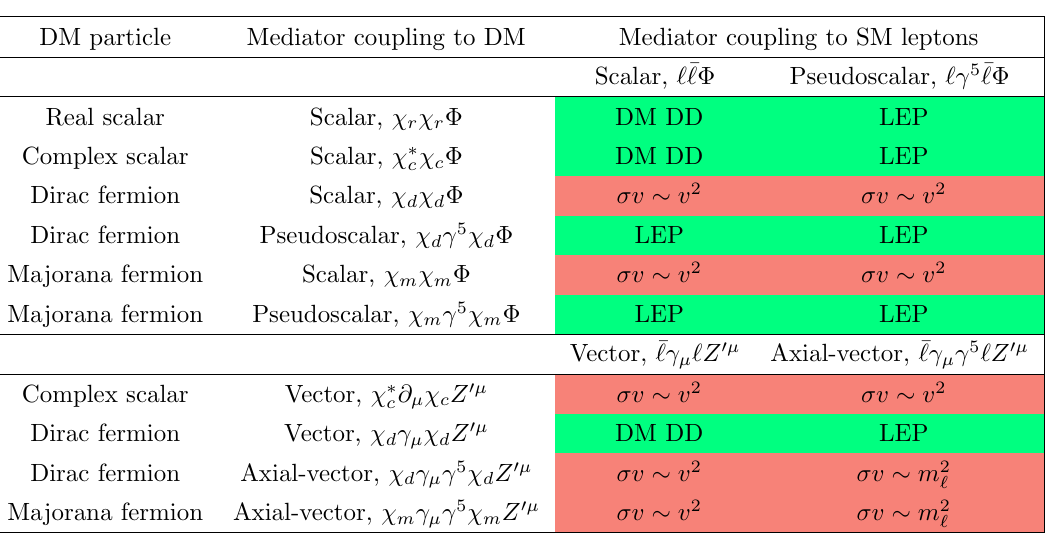
Table 1 . Combinations of possible (spin 0 or 1) mediator couplings to SM leptons (columns) and DM (rows). For each possibility, we indicate the strictest constraint on the parameter space explaining the DAMPE excess (colored green) or indicate suppression that rules it out as an ex- planation of the DAMPE excess (colored red), where DM DD indicates the spin-independent DM direct detection constraints currently provided by